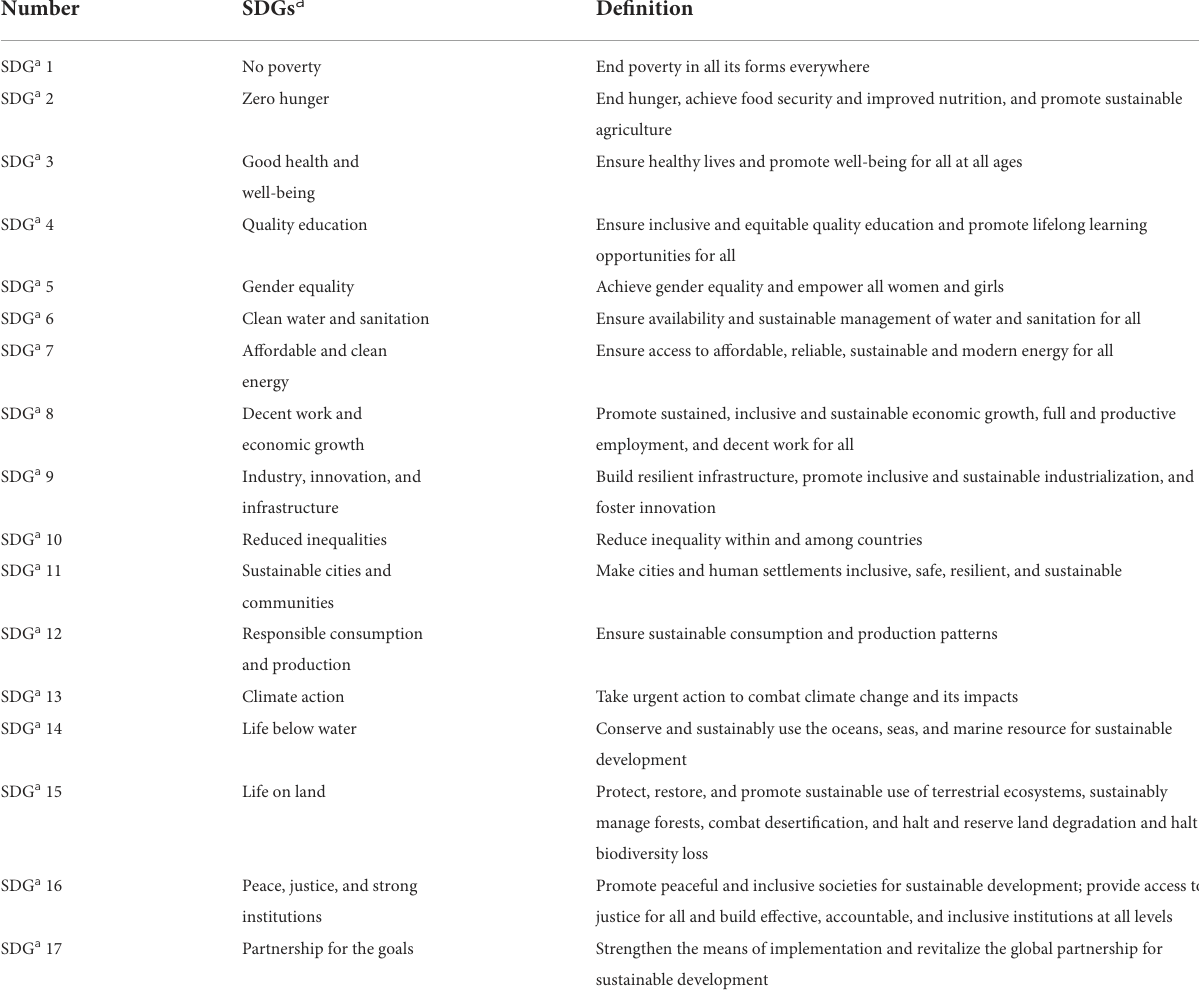
TABLE 2 Sustainable development goals and their definitions bc , sustainable development goals, one health, India,